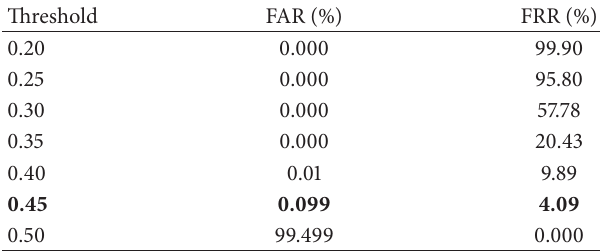
Table 3: Best FAR, FRR, and corresponding threshold for Experiment 2.